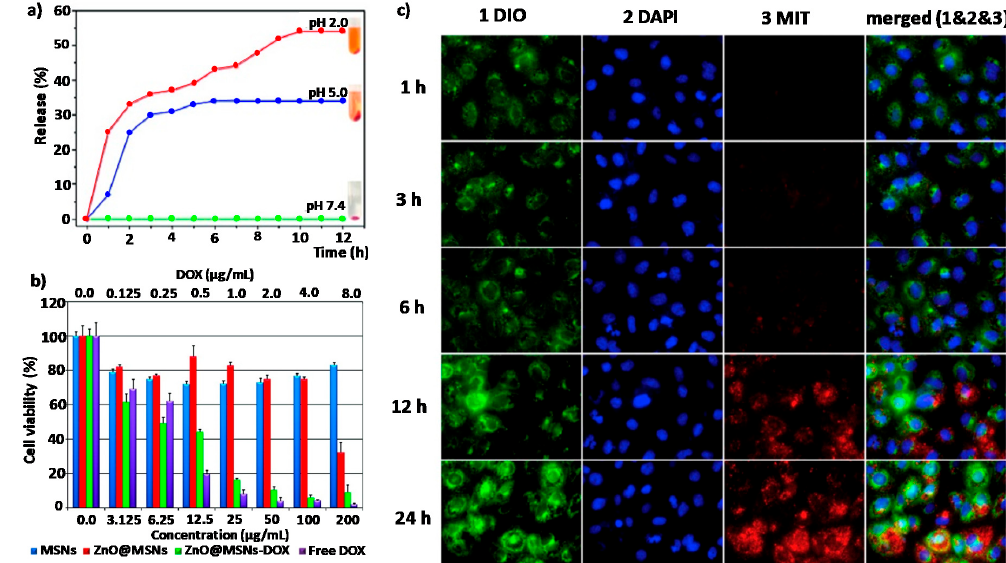
Figure 5. ( a ) DOX release profiles from ZnO@MSNsDOX at 3 different pH values (7.4, 5.0, and 2.0); ( b ) In vitro viability of HeLa cells in the presence of COOHMSNs, ZnO@MSNs, ZnO@MSNsDOX, and free DOX. Reproduced with permission from [56]. American Chemical Society, 2011. ( c ) Confocal microscopy images taken at different times of A549 cells incubated with the MIT-loaded, ZnO-gated MCNs. Cell membranes were stained in green, cell nuclei were stained in blue and released drugs wre presented red. Reproduced with permission from [60]. Elsevier, 2016.